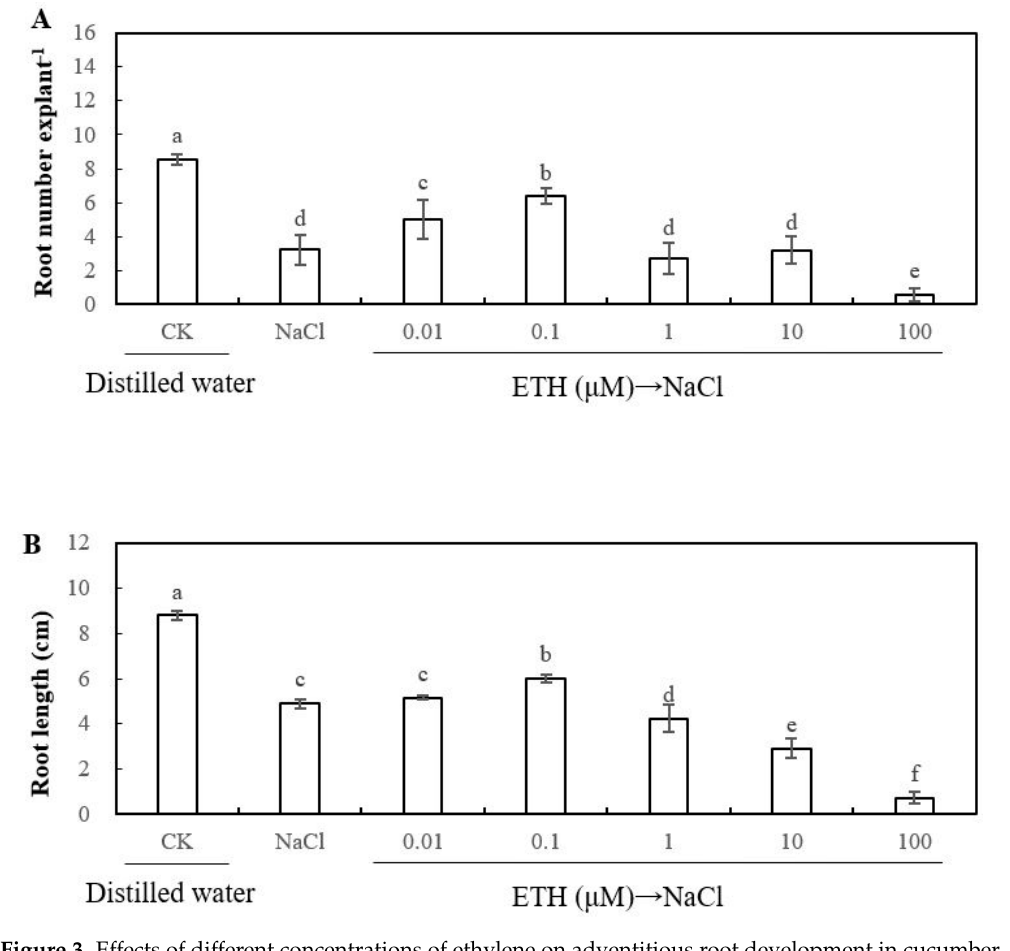
Figure 3. Effects of different concentrations of ethylene on adventitious root development in cucumber explants under salt stress. The primary roots were removed from hypocotyl of five-day-old seedlings. Explants were incubated for five days with distilled water as control. Explants were incubated with 13 mM NaCl in three days after being treated with distilled water or different concentrations of ethylene donor 2-chloroethylphosphonic acid (ethrel) treatments for two days, respectively. The numbers ( A ) and root length ( B ) of adventitious root were expressed as mean ± SE ( n = 3, 10 explants were used per replicate). Bars with different lowercase letters were significantly different by Duncan’s multiple range test ( P <